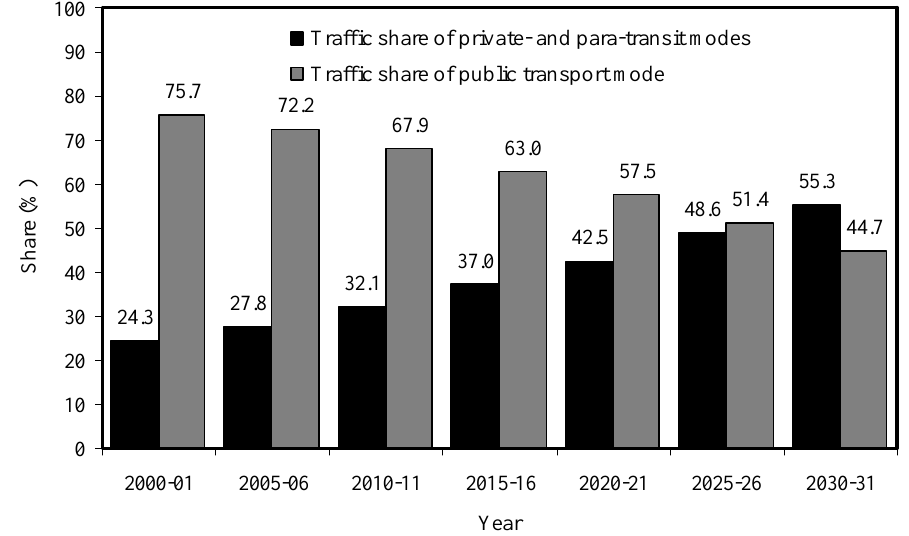
Figure 3. Projected modal split changes during the next three